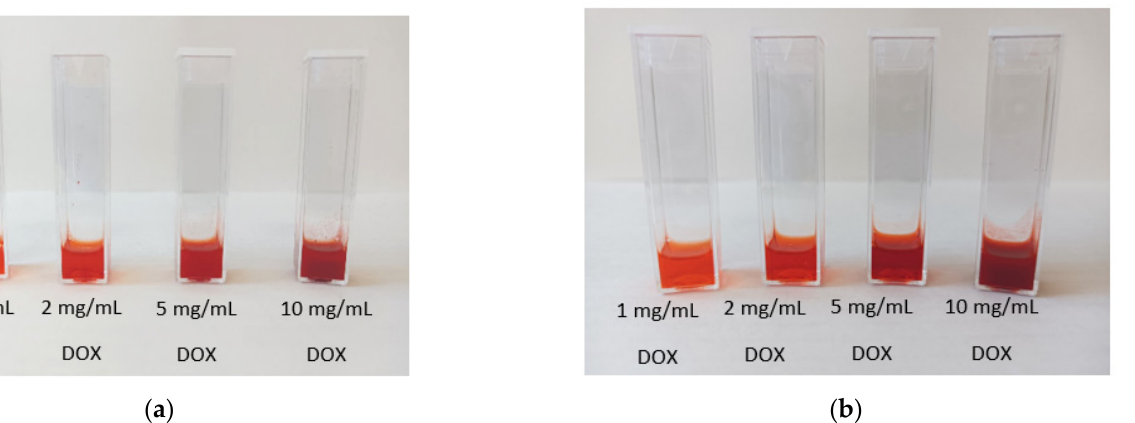
Figure 6. Images of the Doxorubicin-loaded IL/Water emulsions prepared at ( a ) 10IL/Water, and ( b ) 25IL/Water.